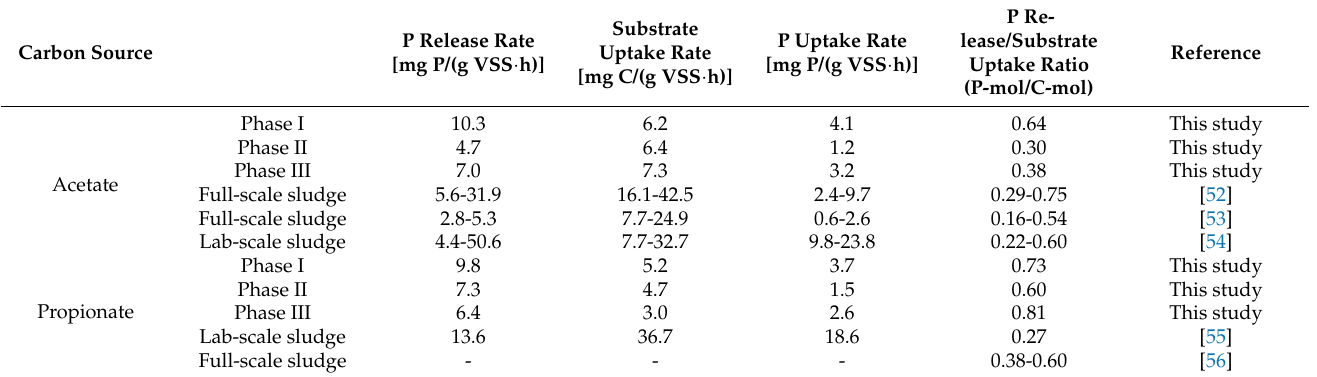
Table 2. Specific kinetic rates and stoichiometric ratios observed in the P release and uptake batch tests fed with different carbon sources during the